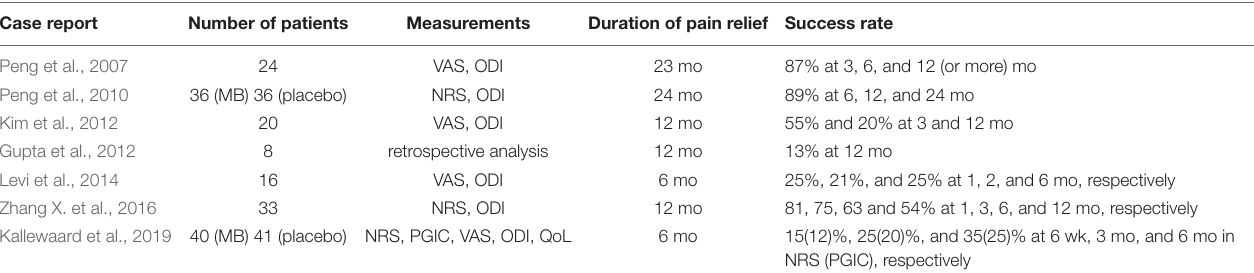
TABLE 2 | Overall results of intradiscal MB Injection in CDLBP